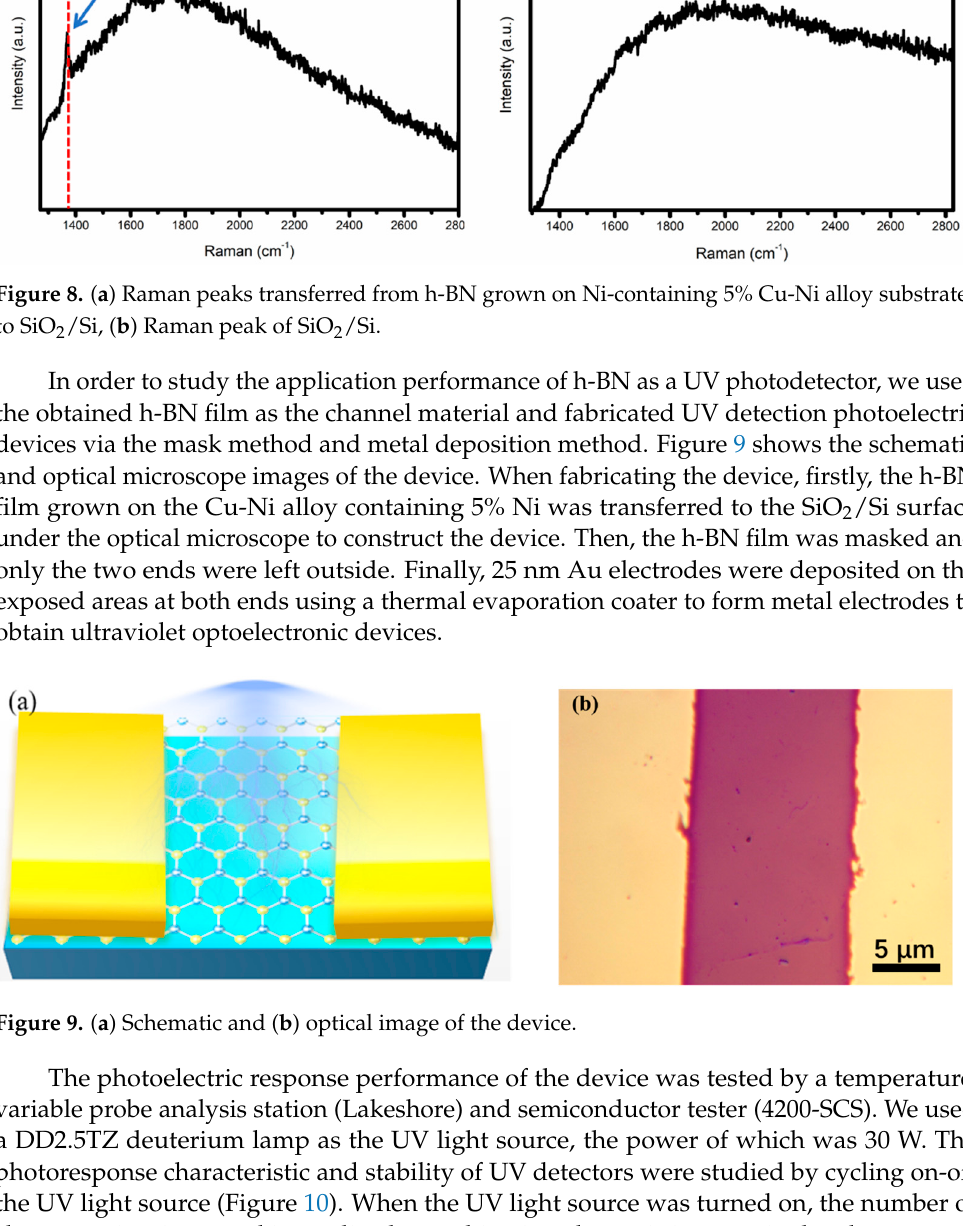
Figure 7. XPS peaks of h-BN. ( a ) B 1s, ( b ) N 1s.